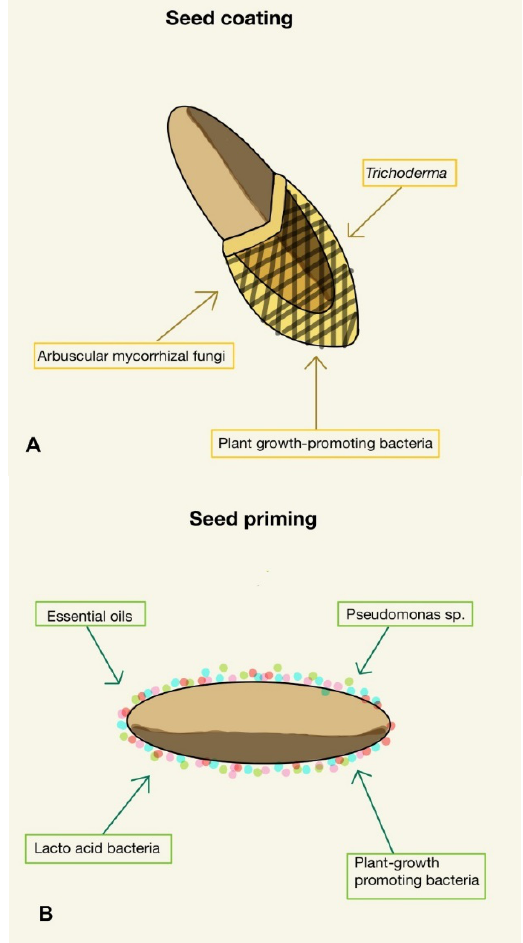
Figure 2. Microorganisms that can be used in ( A ) seed coating and ( B ) seed priming. An increase in grain yield and stability has been associated with seed coating formu- lation with the AM fungi and Trichoderma consortium with reduced or withheld fertilizer application in winter wheat, wheat, and maize [70–72]. Various studies on biocontrol agents (BCA) and inducers of systemic acquired resistance (SAR) were carried out to the end of reducing the fungicide administration. Perell ó and Dal Bello [73] validated the effects of T. harzianum strains and synthetic compounds (acibenzolar-S-methyl and thiamethoxam) on wheat growth and the suppression of tan spot caused by Pyrenophora tritici-repentis . Biological and chemical agents are both used as SAR inducers. The study showed that both biological and chemical agents can reduce the severity of tan spots and increase the plant height and weight. Activation of SAR in plants can maintain crops as healthy and vigorous. The correct combination of SAR inducers applied via seed coating and lower-concentration fungicides is a promising option for sustainable